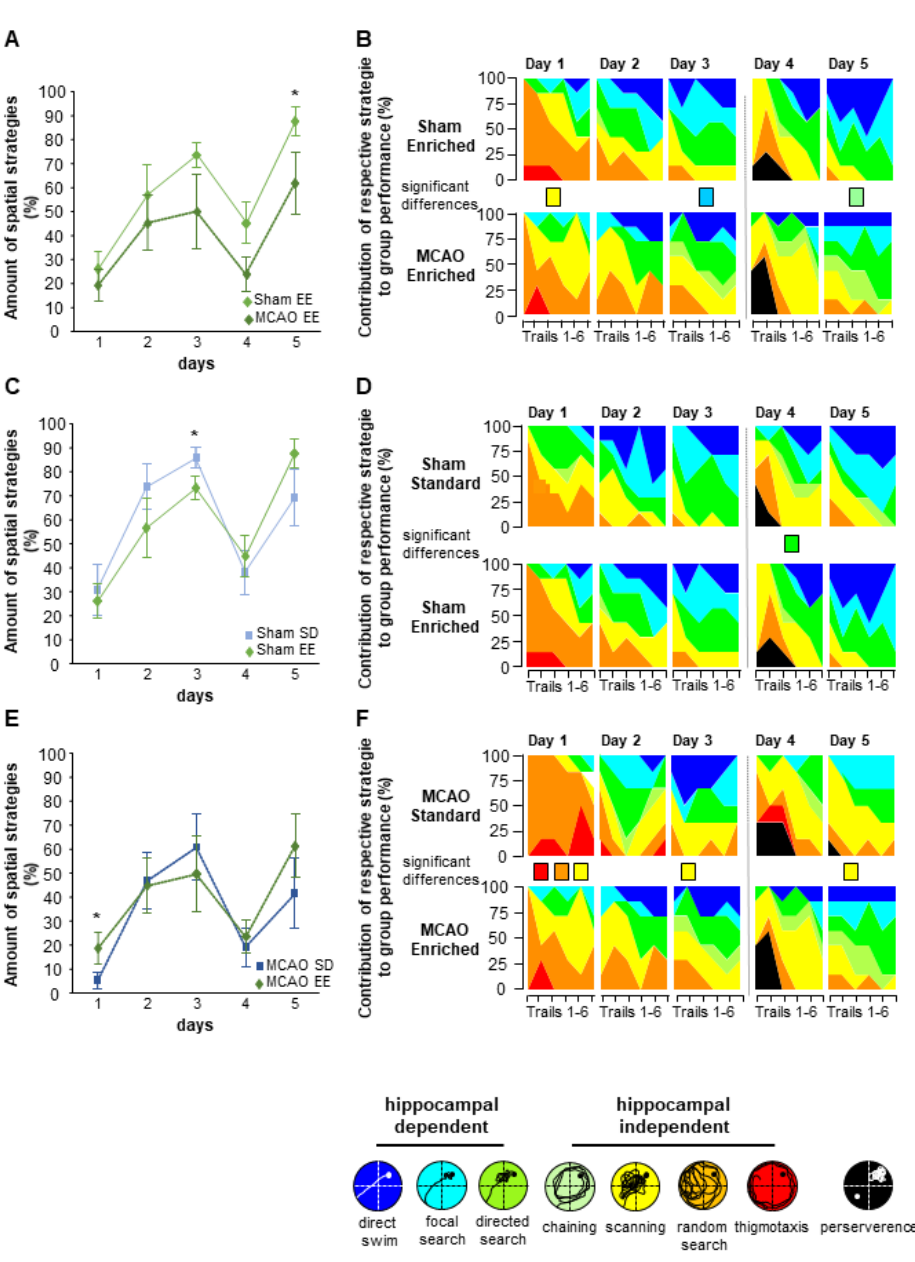
Figure 9. Analysis of hippocampus-dependent and independent search strategies in the MWM test. ( A , C , E ) Representation of hippocampus-dependent strategies over time. The data show an improved learning behavior in the EE sham group compared with the EE MCAO. Furthermore, there was more frequent use of the hippocampus-dependent strategies on day 1 in the MCAO-EE group compared with the MCAO-SD group. ( B ) Within the hippocampus-independent strategies, the MCAO-SD animals showed increased use of the scanning strategy on day 5. For analysis of the different hippocampal-dependent and -independent search strategies on each day, an exploratory data analysis by means of an algorithm based on the generalized estimating equations method was performed. Significant differences in strategies usage are represented by colorful squares for each day, * p < 0.05.